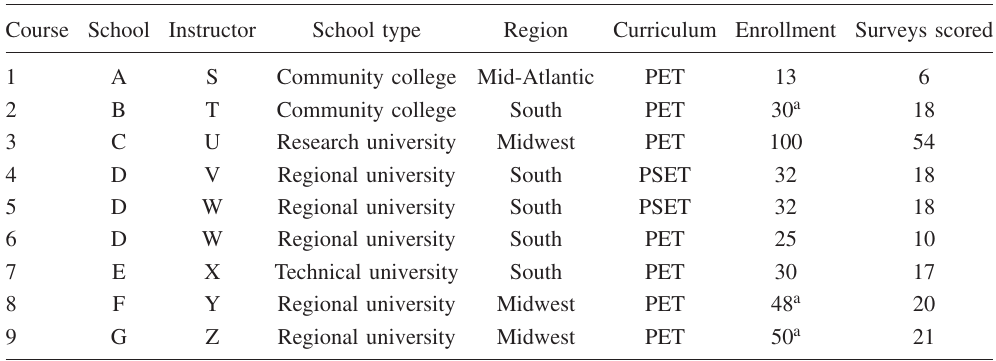
TABLE I. Characteristics of schools and